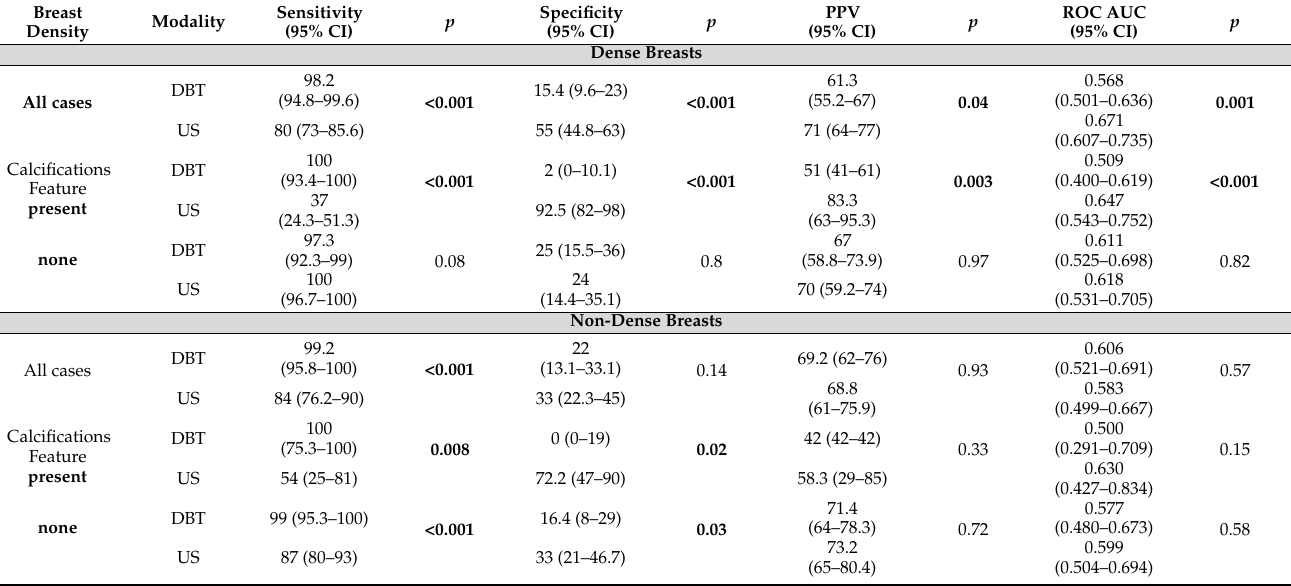
Table 3. Diagnostic performance of DBT and ultrasound across dense and non-dense breasts.